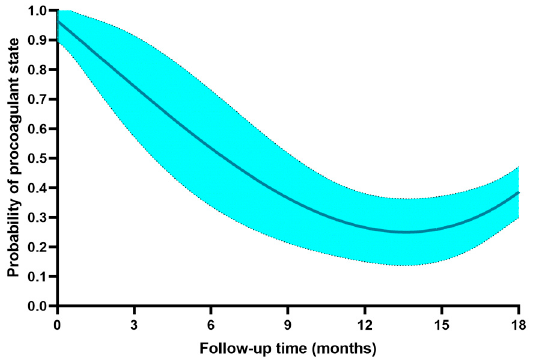
Figure 1. Probability of the persistence of a procoagulant state. Cubic regression function with 95% confidence interval bands.